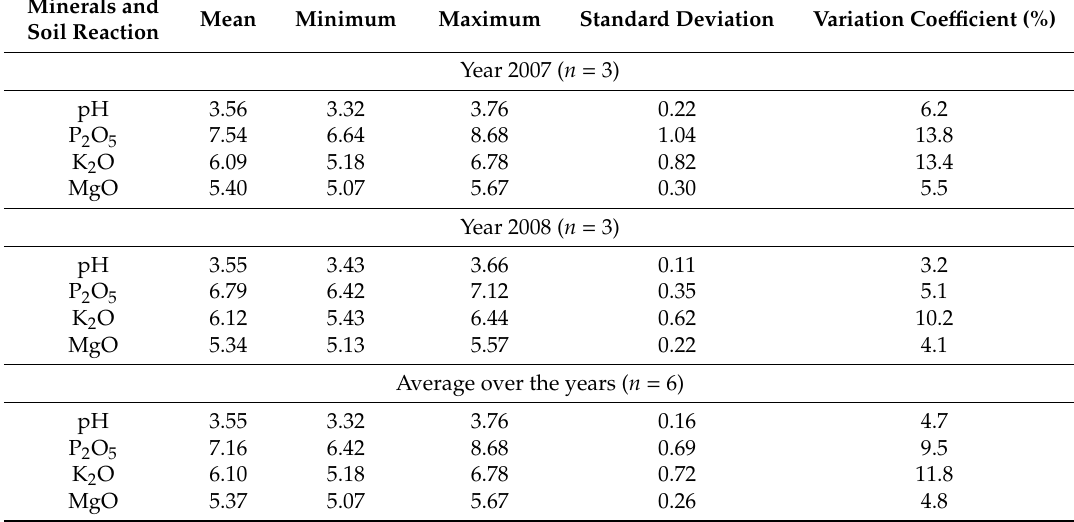
Table 2. Characteristics of soil conditions of a forest habitat located in Location I (mg · 100 g − 1 soil). Minerals